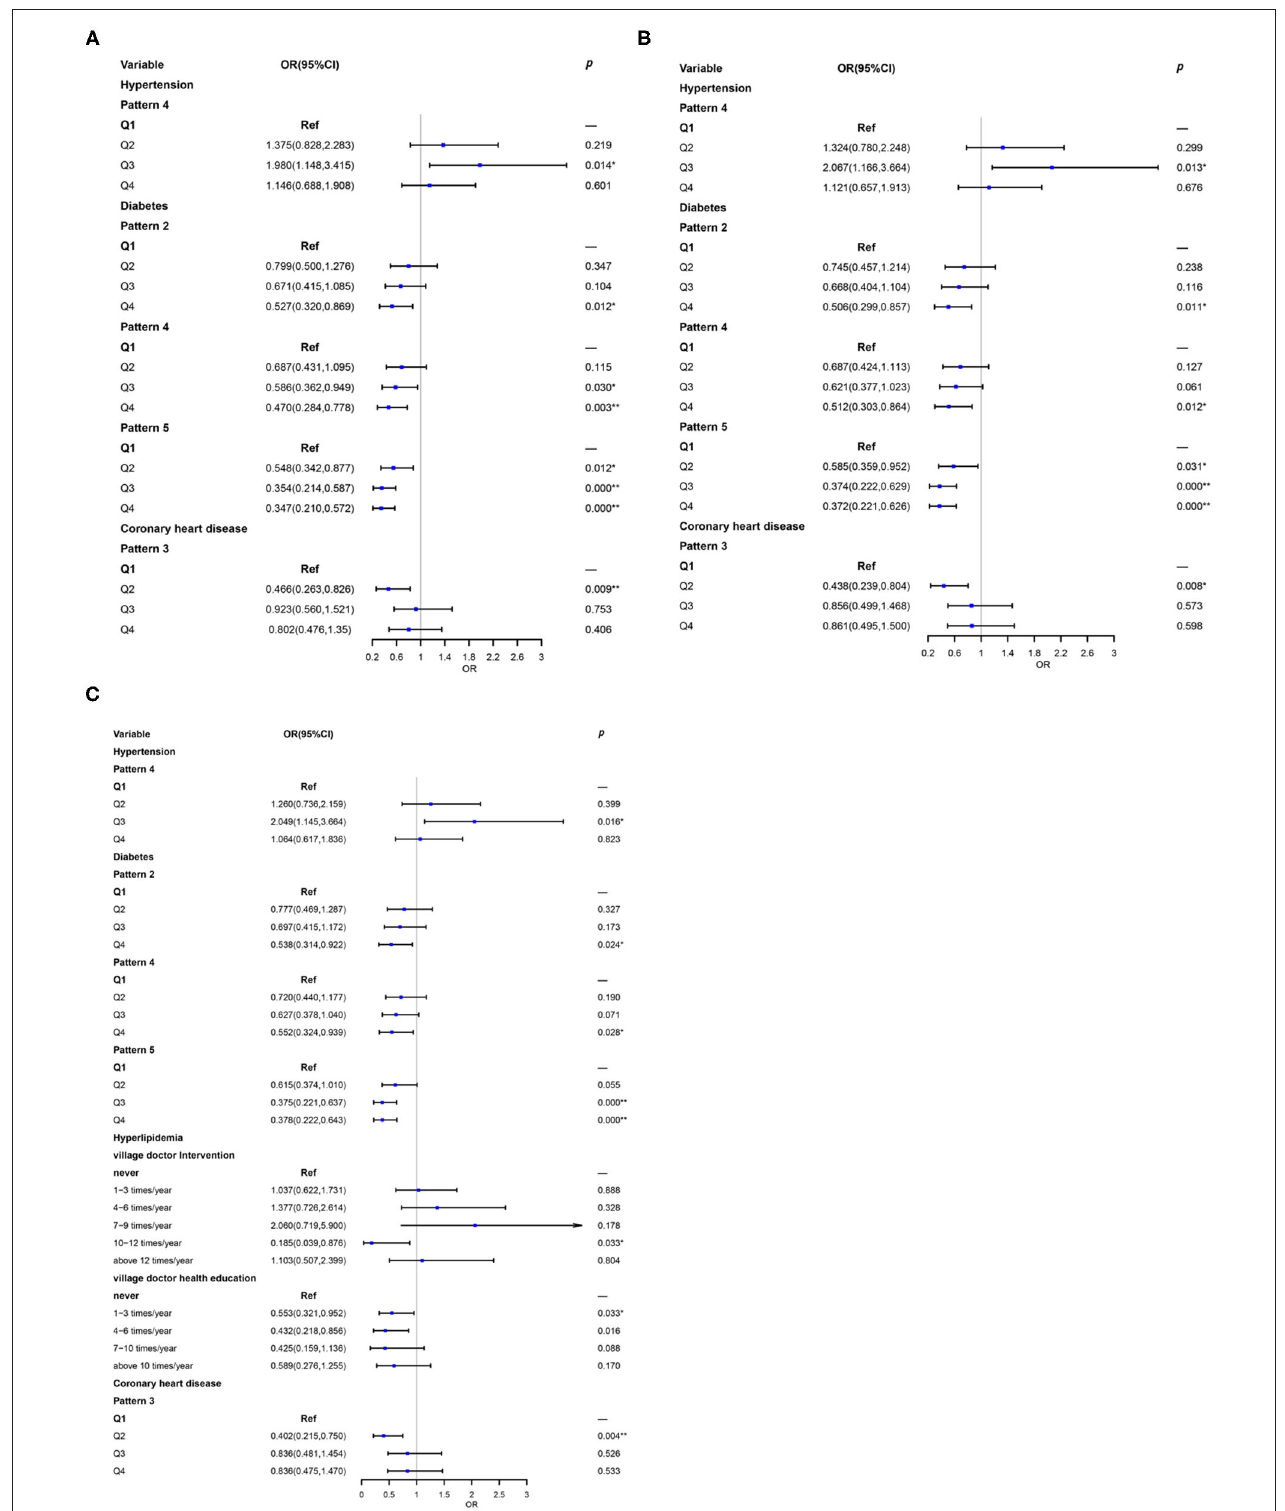
FIGURE 1 | Association between dietary patterns and prevalent metabolic diseases (A) unadjusted; (B) Model 1: adjusted for sex, age, education, marital status, nation, body mass index (BMI), and income; (C) Model 2: add community doctor follow-up, village doctor intervention, and village doctor health education based on Model 1. Q1 was the reference group. * p < 0.05, ** p < 0.01.